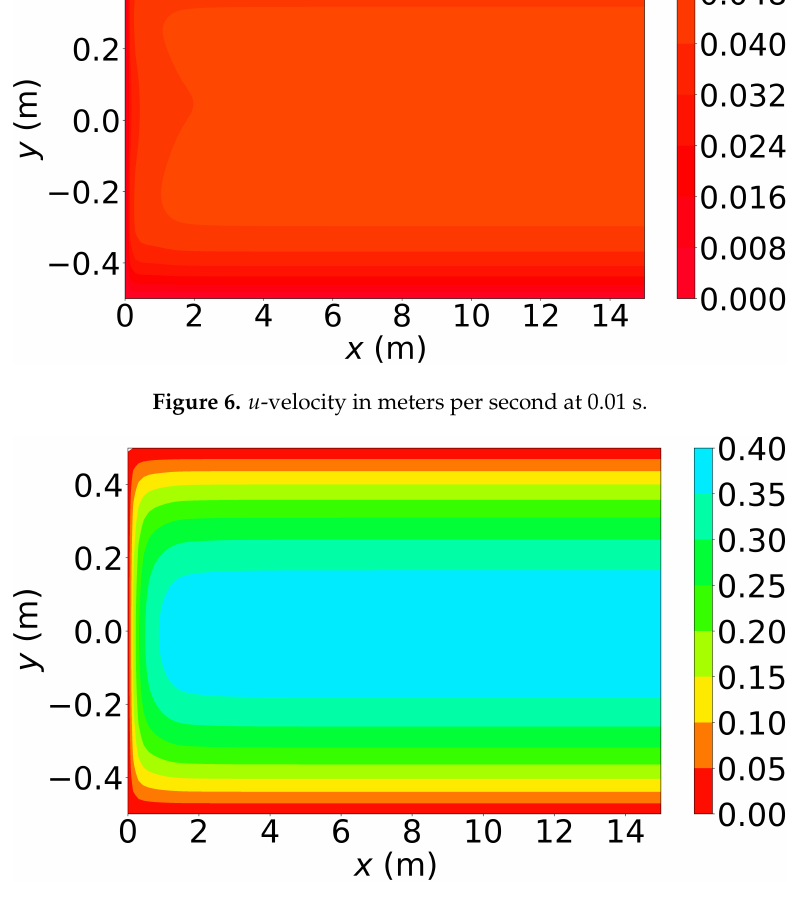
Figure 7. u -velocity in meters per second at 0.1